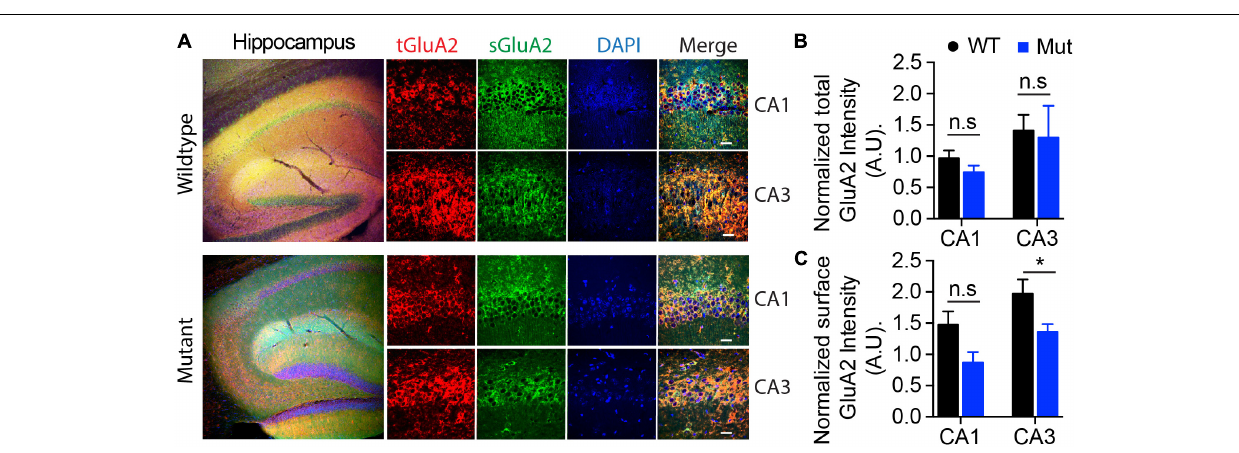
An input/output curve representing synaptic responses (fEPSP slope/fiber volley) resulting from different stimulus intensities ( Figure 8 ). Synaptic responses were significantly lower in A350V IQSEC2 mice as compared to WT IQSEC2 mice. These